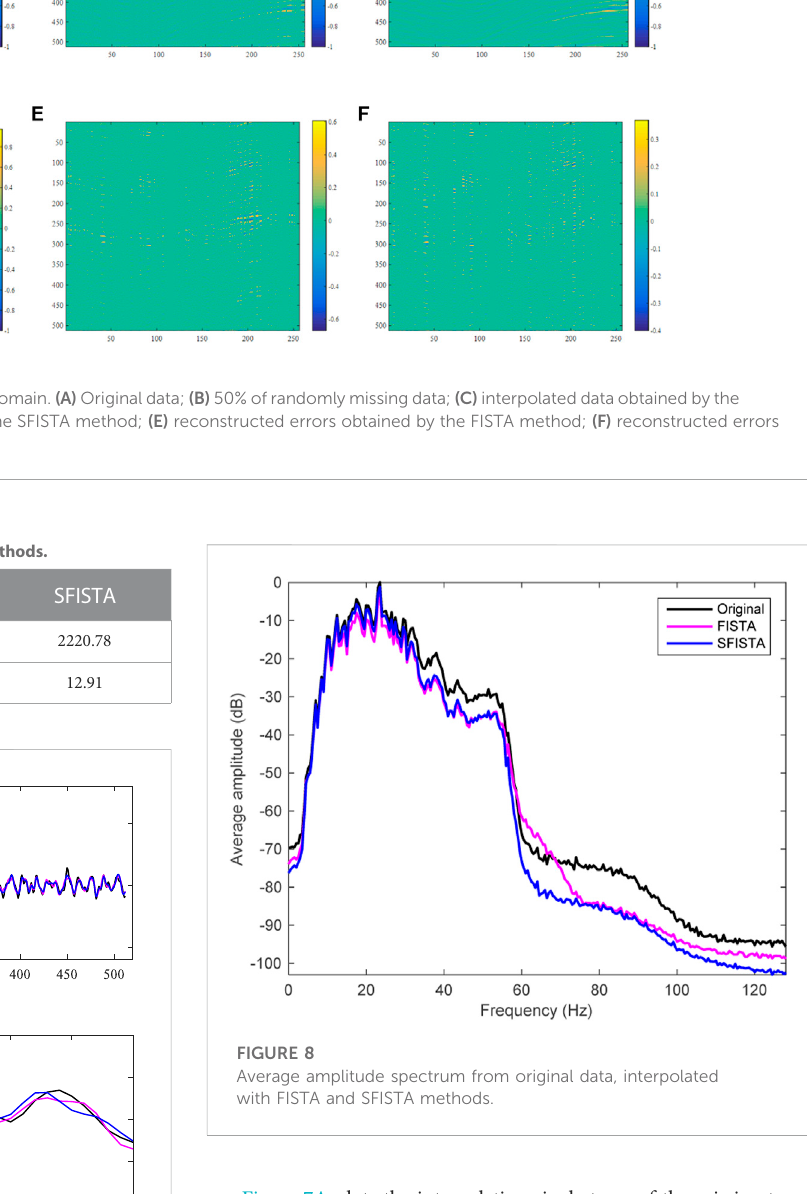
Figure 7A plots the interpolation single trace of the missing trace with zero values. In Figures 7, the black, pink, and blue lines correspond to the original data and those obtained by FISTA and SFISTA methods, respectively. Figure 7B shows the zoomed traces from the transparent gray window of Figure 7A. A detailed comparison reveals that the blue line is similar to the black line. We can, therefore, af fi rm that the proposed SFISTA method can better restore the signi fi cant features of the useful signal than the FISTA method. Comparing the detailed values in Tables 5, 6, the SFISTA method in the curvelet domain is better than that in the contourlet domain.